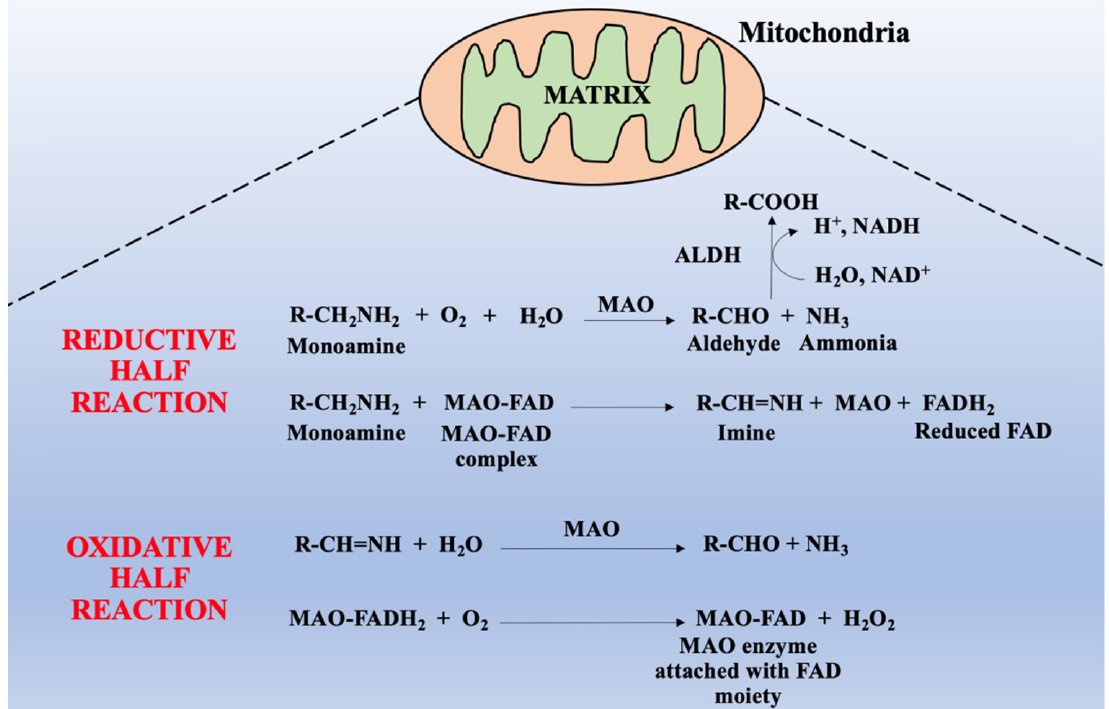
Figure 2. Possible reaction of monoamine-catalyzed generation of reactive species via two successive reactions viz. reductive half-reaction and oxidative half-reaction, leading to oxidative stress. Legend: MAO—monoamine oxidase; FAD—flavin adenine dinucleotide; FADH 2 —reduced flavin adenine dinucleotide; MAO-FAD—monoamine oxidase-flavin adenine dinucleotide complex; H 2 O 2 —hydrogen peroxide; ALDH—aldehyde dehydrogenase; NADH—nicotinamide adenine dinulceotide; NH 3 —ammonia.